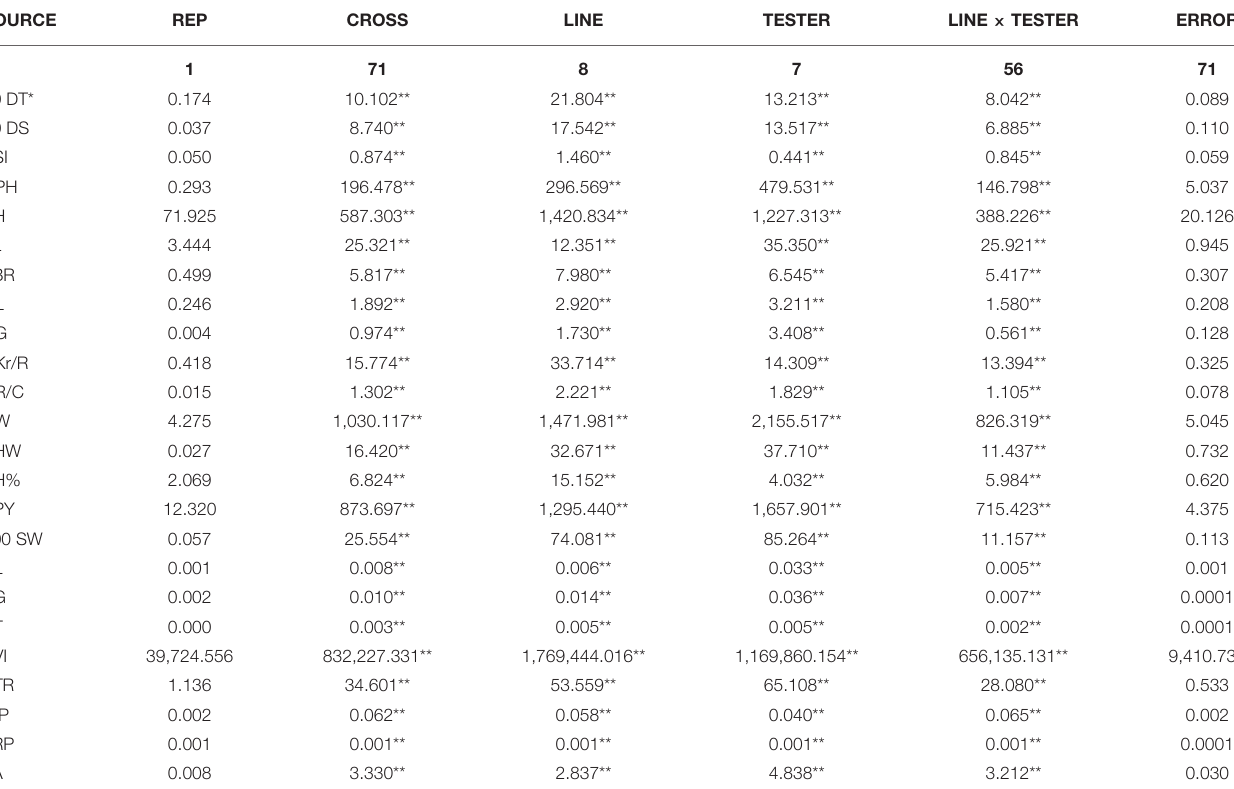
TABLE 3 | ANOVA for combining ability across locations.